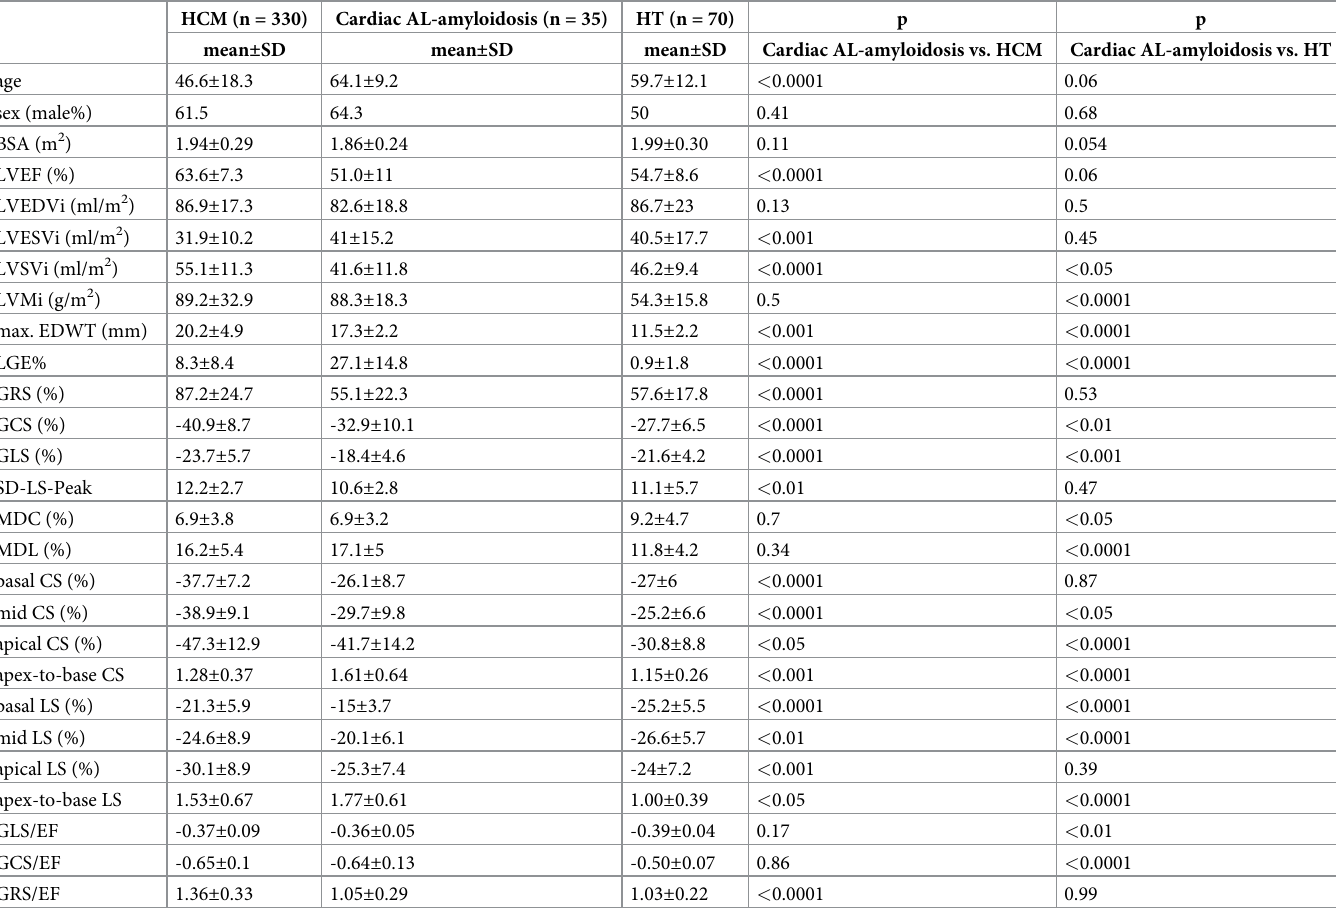
Table 1. Demographic and CMR characteristics of the study